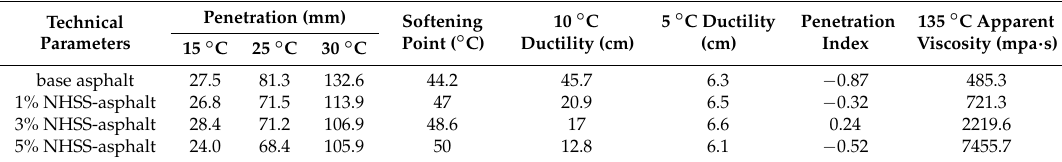
Table 4. Property parameters of modified asphalt with different